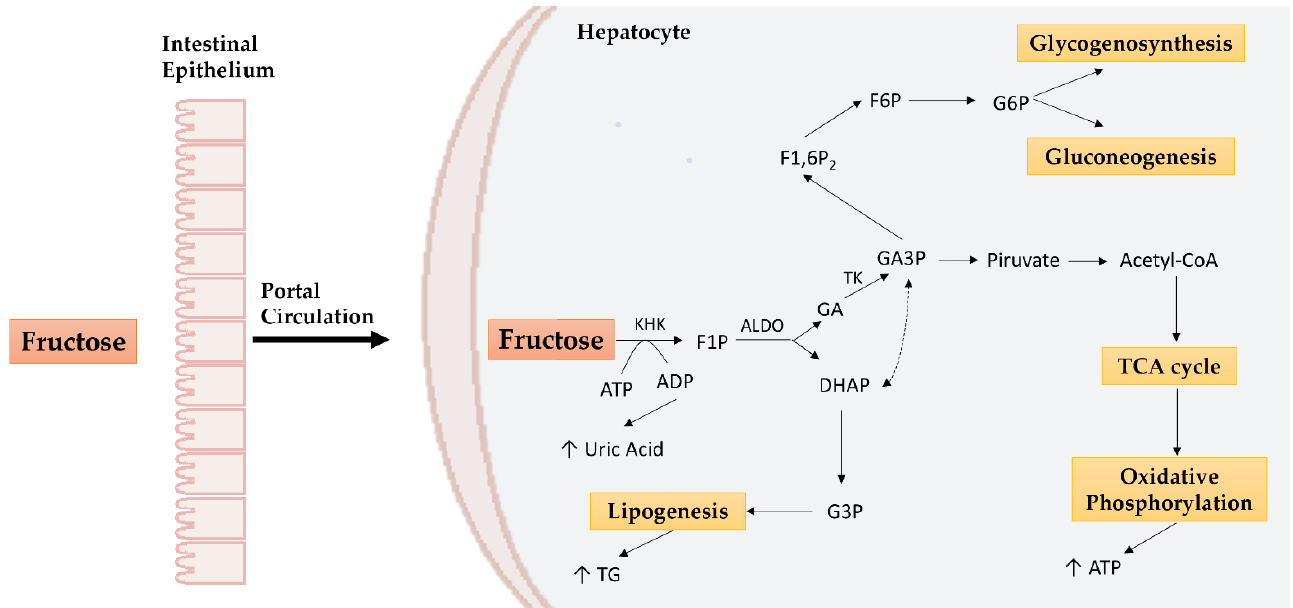
Figure 1. Hepatic fructose metabolism. In the liver, fructose undergoes KHK phosphorylation to obtain F1P. F1P obtained is metabolized to DHAP and GA by ALDO. DHAP is converted to G3P which enters the lipogenesis mechanisms. On the other hand, GA is converted to GA3P by TK. GA3P can promote lipogenesis after being converted to DHAP, but it can also generate pyruvate, involved, in turn, in the TCA cycle and oxidative phosphorylation to obtain ATP. GA3P is also a precursor of G6P used for gluconeogenesis or glycogenosynthesis. KHK: ketohexokinase; ALDO: aldolase; TK: triose kinase; ATP: adenosine triphosphate; ADP: adenosine diphosphate; F1P: fructose-1-phosphate; DHAP: dihydroxyacetone phosphate; G3P: glycerol 3-phosphate; GA: glyceraldehyde; GA3P: glyceraldehyde 3-phosphate; F1,6P 2 : fructose-1,6-bisphosphate; F6P: fructose-6-phosphate; G6P: glucose-6-phosphate; TG: triglycerides; TCA: tricarboxylic acid cycle.